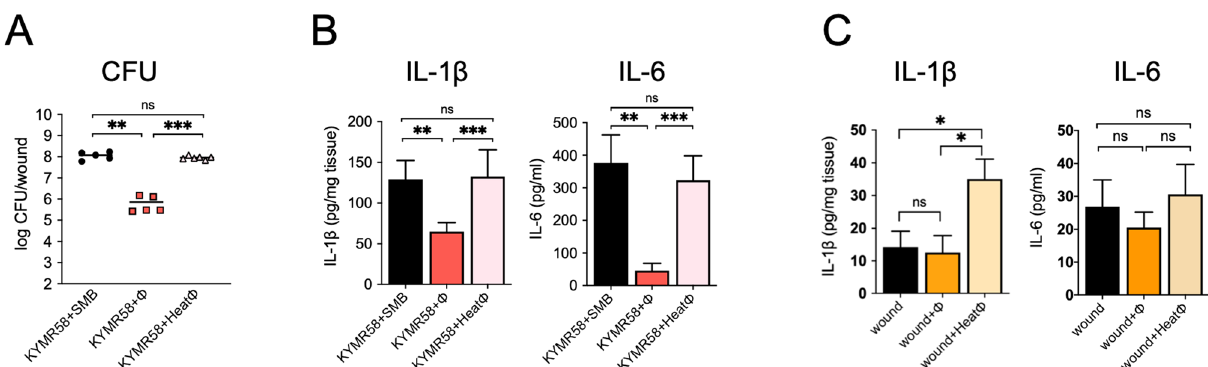
Figure 8. Effects of heat inactivation of phiMR003 on the bacterial load and cytokine production. ( A ) The number of bacteria in the tissue was quantified 48 h after infection. The results represent the mean CFU/ wound (n = 5 or 6). ( B ) IL-1β and IL-6 were quantified using the samples prepared at 24 h after KYMR58 infection followed by the administration of mature phiMR003 (KYMR58 + ϕ), heat-inactivated phiMR003 (KYMR58 + Heatϕ) or SM buffer (KYMR58 + SMB). ( C ) Active and heat-inactivated phiMR003 were administered to the excised skin, and IL-1β and IL-6 were quantified at 24 h after infection and phage administration. Data show the mean of a number of samples (n = 5 or 6). Error bars indicate the standard errors of the means (SEMs). *, P < 0.05; **, P <